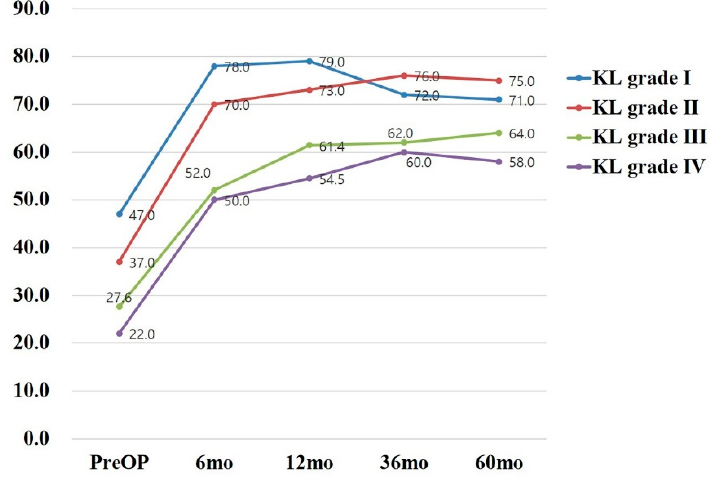
Figure 6. Lysholm Knee Questionnaire/Tegner Activity (LKQ) according to the K-L grade.